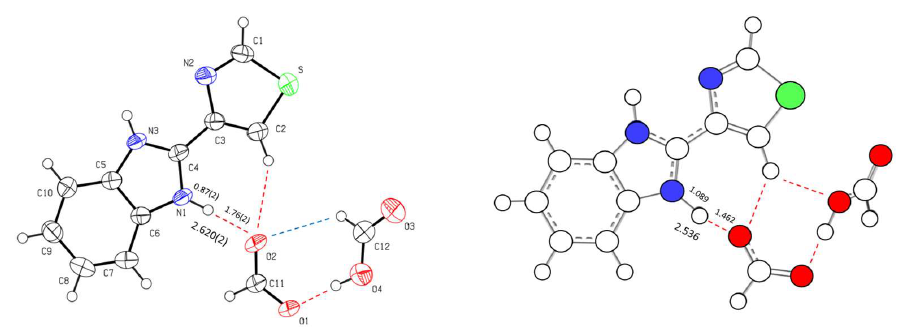
Figure 8. Structure of the (TBZ-H) + .HCOO – .HCOOH structural unit obtained by X-ray diffraction (ORTEP plot of the anisotropic displacement ellipsoids drawn at the 50% probability level; left) and the optimized structure resulting from the performed computational calculations (right). The distances are in Å.